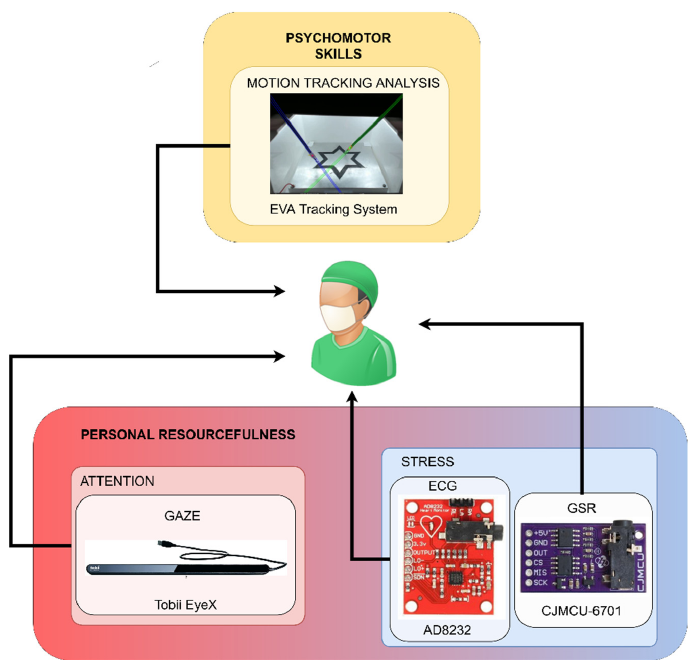
Figure 2. Monitoring parameters in the designed experiment.